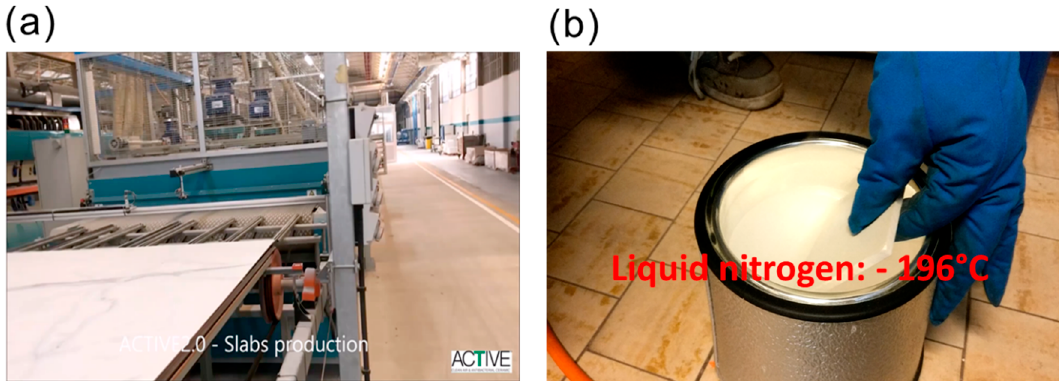
Figure 1. ( a ) Synthesis of commercial Ag@TiO 2 photoactive porcelain-grès tiles via digital printing production. ( b ) Stability of the Ag@TiO 2 photoactive porcelain-grès tiles.